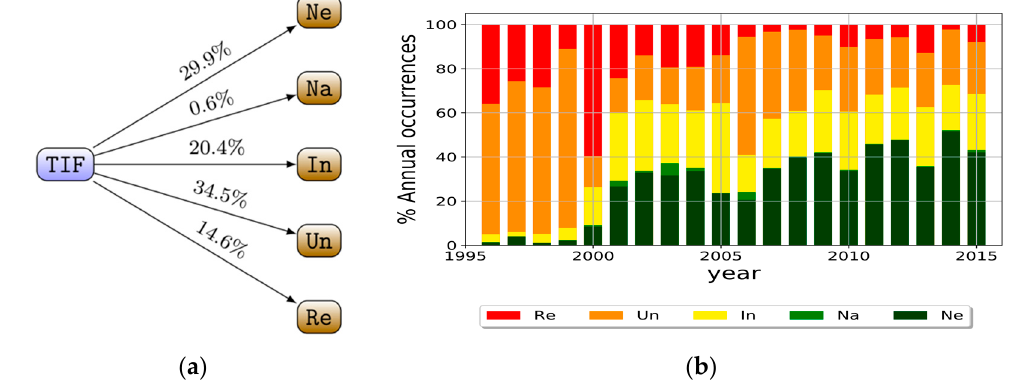
Figure 9. Causes of fires in mainland Portugal; ( a ) Relative proportion of each cause in investigated fires; ( b ) Annual distribution of fires by cause.